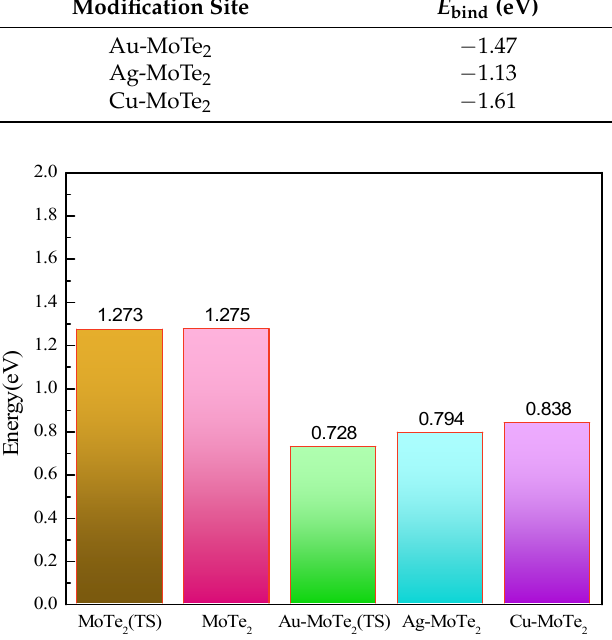
Table 1. Binding energy and charge transfer of TM atoms modification on MoTe 2 .